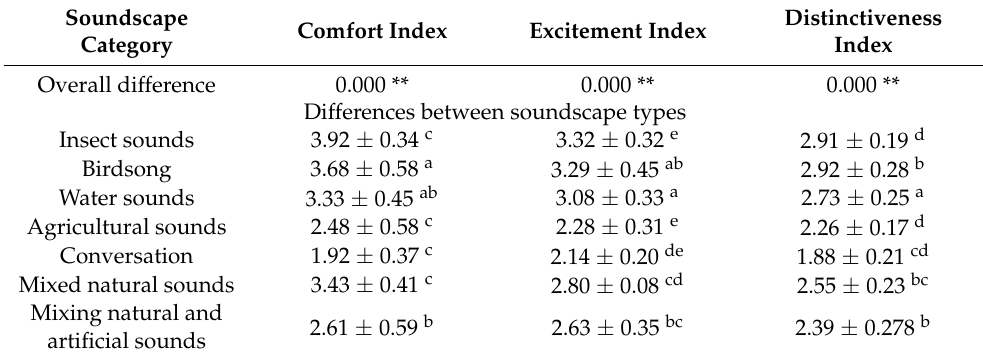
Table 4. The effects of different soundscapes on human psychology.